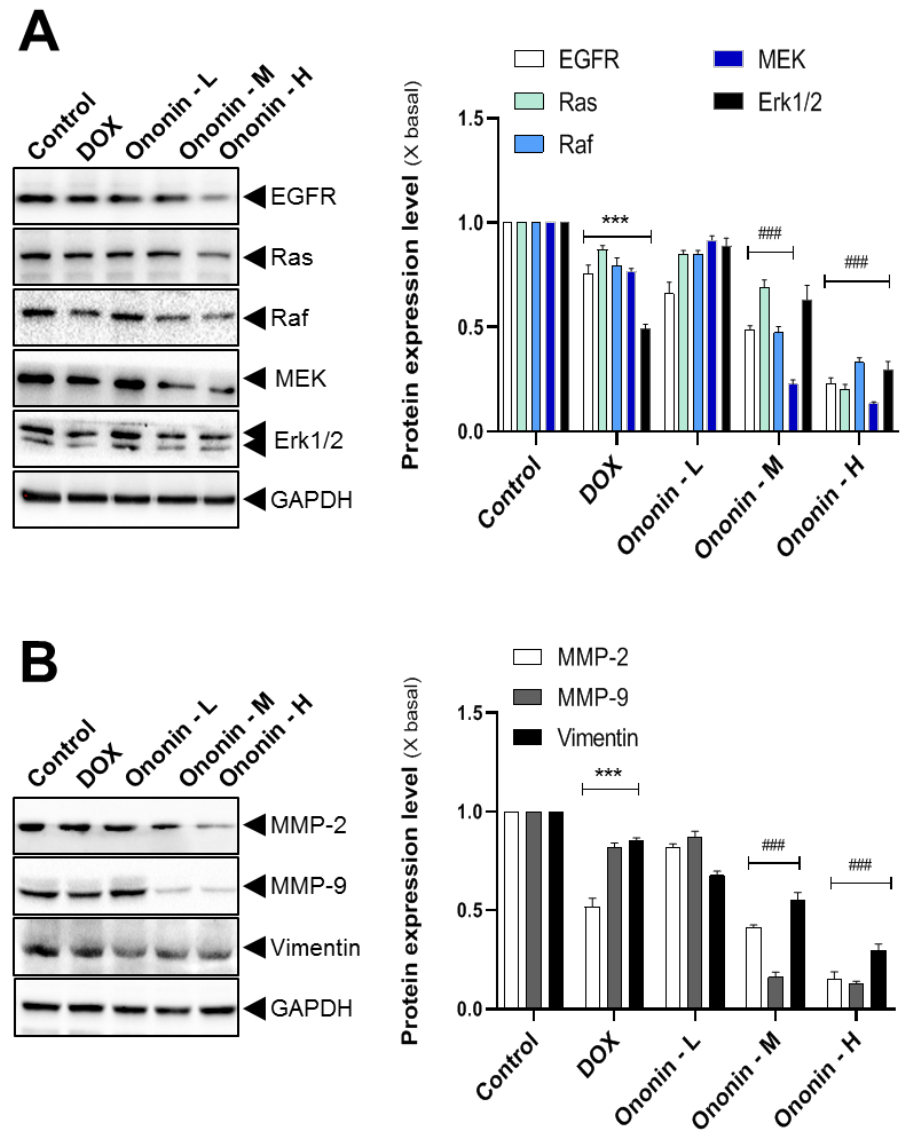
Figure 9. The homogenized tumor cell was subjected to SDS-PAGE for determining the target genes ( A , B ) translational functions. GAPDH was used as a loading control. The quantification of the target protein was calculated with a densitometer (right panel). The values are expressed as the fold of changes (X basal), in Mean ± SEM, where n = 6. Ononin at 1, 3, and 10 mg/kg/i.p were shown as -L, -M, and -H, respectively. *** p < 0.001 was considered a significant result as compared with the control, and ### p < 0.001 was considered a significant result as compared with the DOX group. Full Western blot images can be found at Supplementary Materials